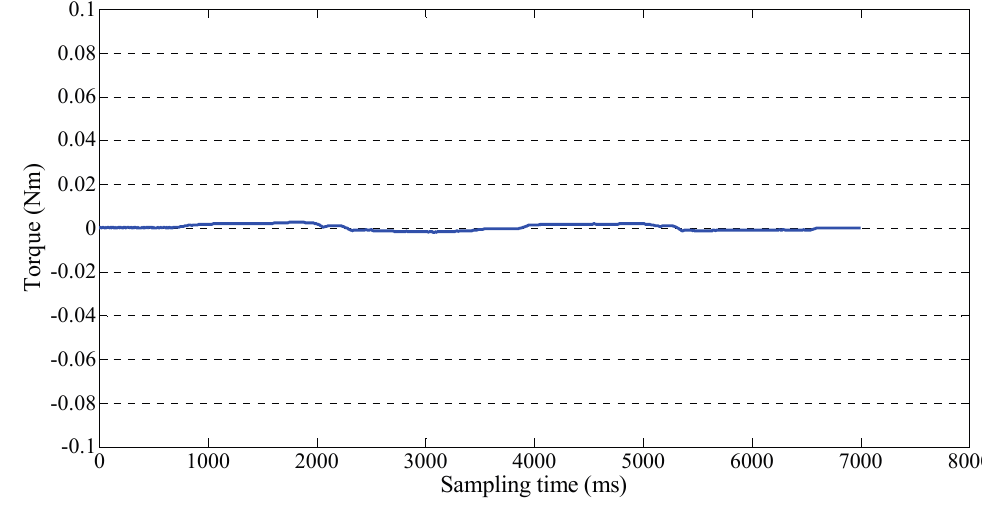
Figure 13. Following of the master device by the exoskeleton device.